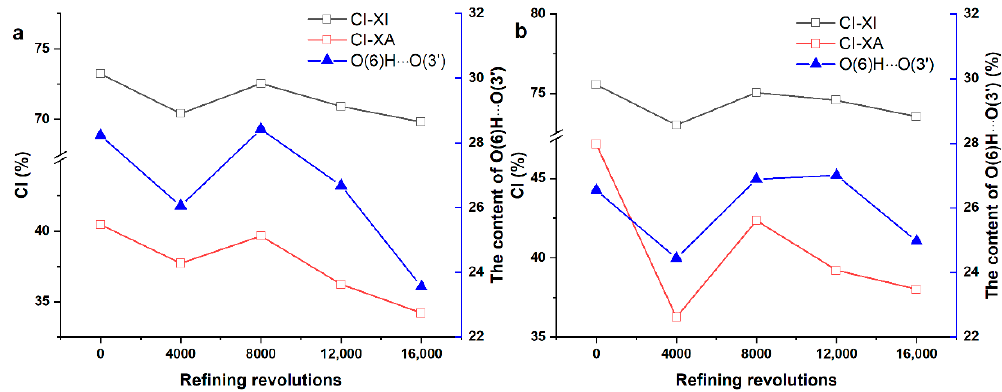
Figure 8. The trend of the CI-XI, the CI-XA, and the O(6)H ⋯ O(3 ′ ) H-bonds: ( a ) softwood fibers and ( b ) hardwood fibers.